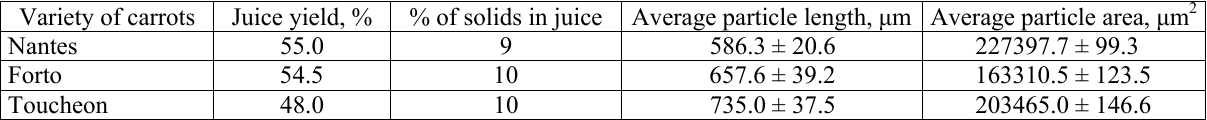
Table 2. Structure of carrot pulp of different varieties after grinding using a centrifugal juicer at a screen rotation rate of 1800 rpm Variety of carrots